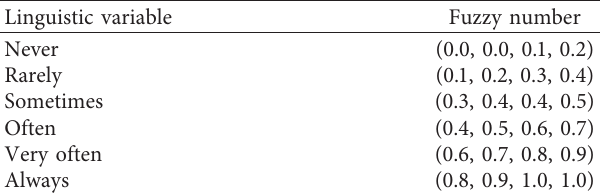
Table 1: Transformation of linguistic variables to fuzzy numbers. Linguistic variable